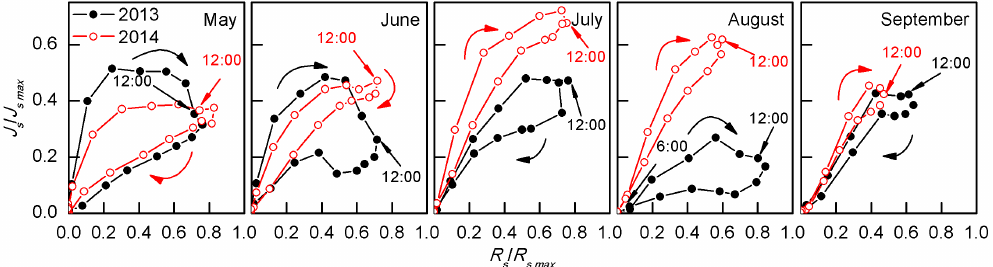
Figure 7. Seasonal variation in hysteresis loops between sap flow per leaf area ( J s ) and shortwave radiation ( R s ) using normalized plots for both 2013 and 2014. The y axis represents the proportion of maximum J s (dimensionless), and the x axis represents the proportion of maximum R s (dimensionless). The curved arrows indicate the clockwise direction of response during the